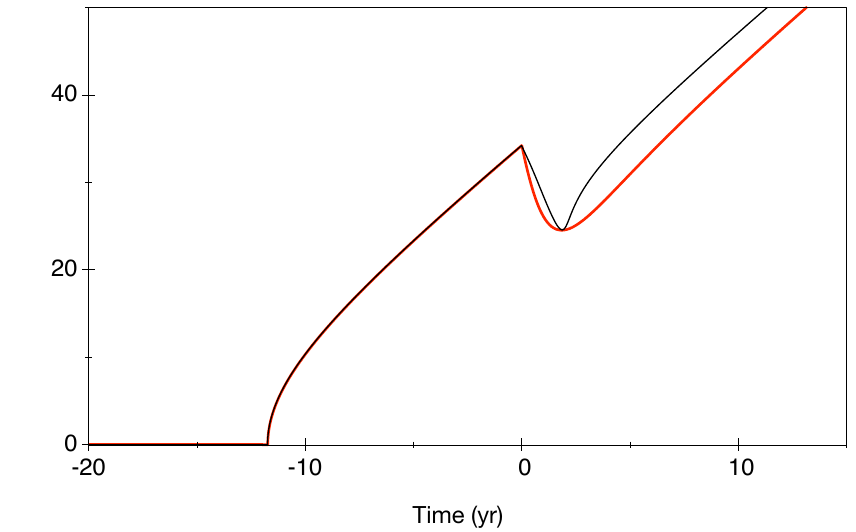
Figure A1. Temporal evolution of the tumor radius versus time for two models: one with a constant death rate (black line) and a fraction of the cell density damaged at the time of RT and a model with a time-dependent death rate (red line). The origin of the time was set to the time of RT. The parameters for the constant death rate model: κ = 1 yr − 1 , D = 1 mm 2 yr − 1 , κ d = 3.3 yr − 1 , x = 0.0053. The parameters for the time-dependent death rate model: κ = 1 yr − 1 , D = 1 mm 2 yr − 1 , κ D = 8.5 yr − 1 , τ d = 0.9